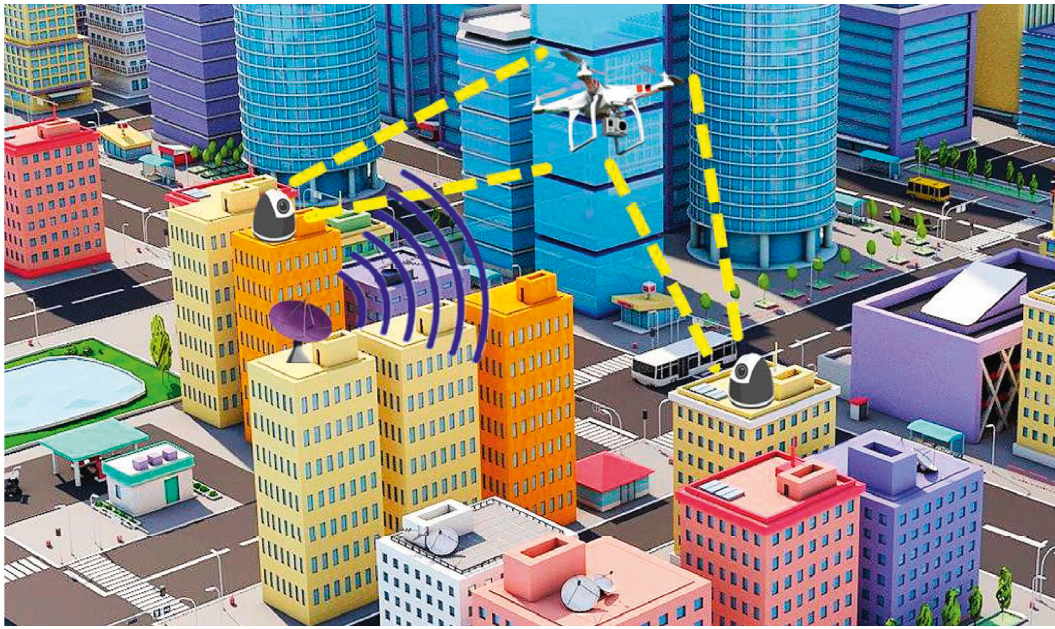
Figure 1: The scene of tracking UAVs with radars and